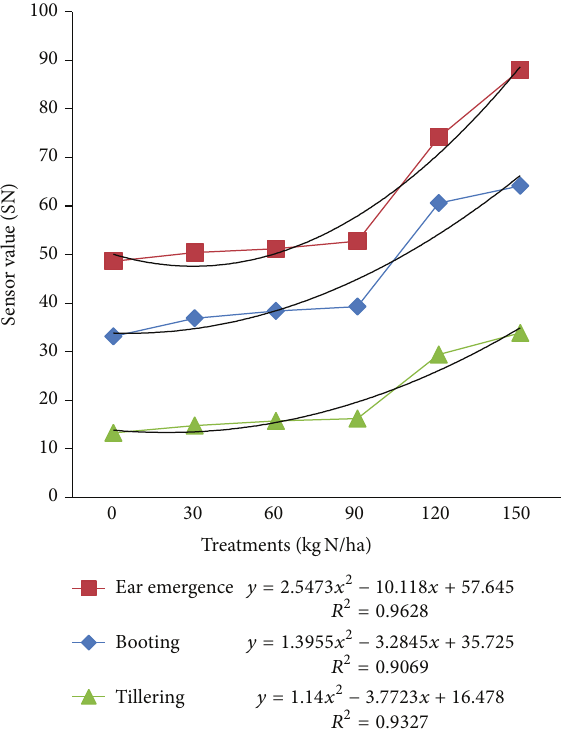
Figure 6: Sensor values for different N-treatments at different crop growth stages.